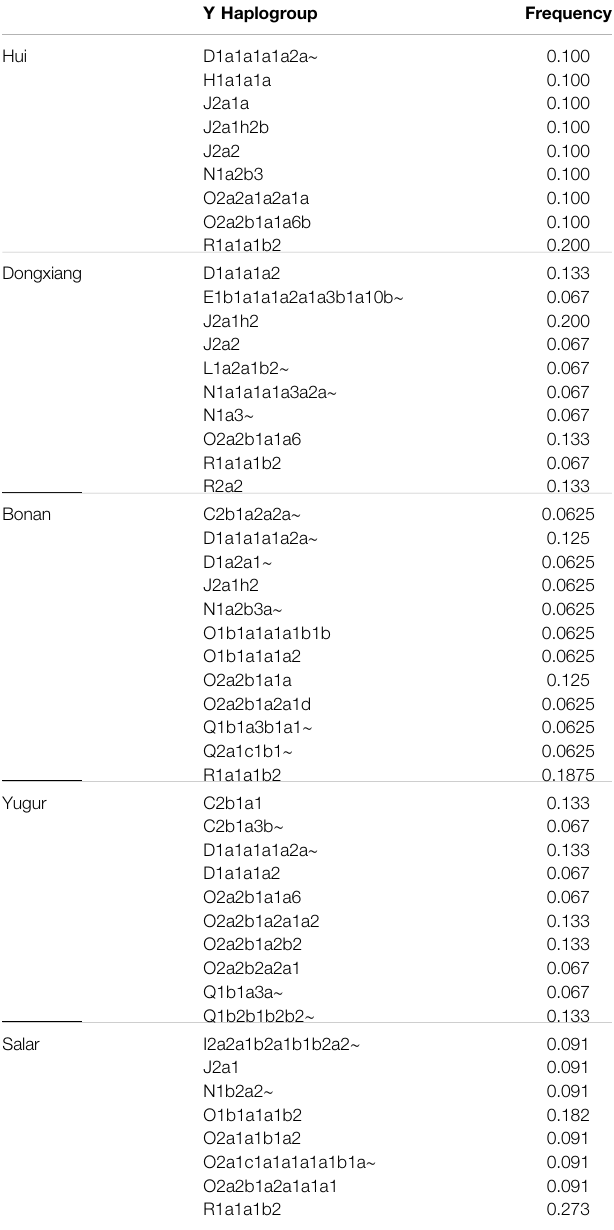
TABLE 3 | The Y-chromosome haplogroups distribution of our studied populations. Y